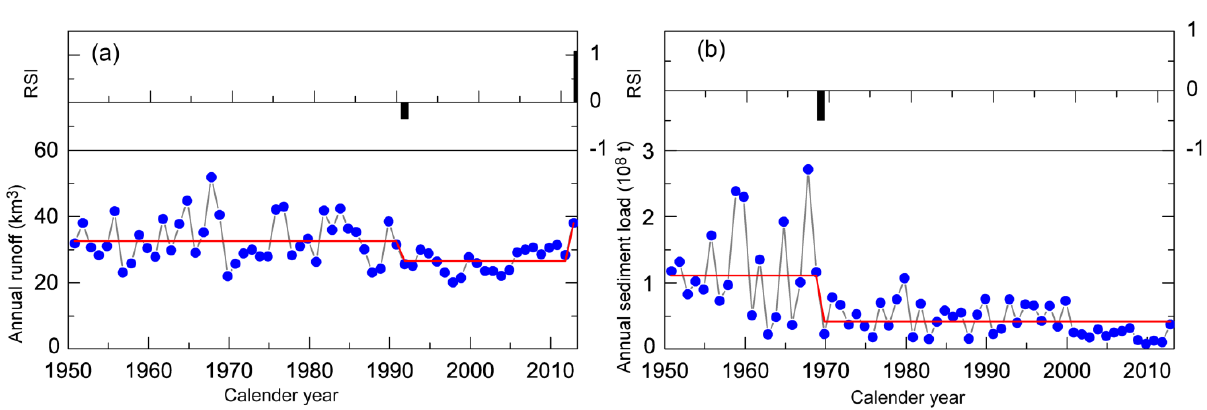
Figure 2. Regime shift detection in the annual runoff and sediment loads at the Lanzhou station. ( a ) Regime shift detected by STARS for annual runoff; ( b ) annual sediment at Lanzhou